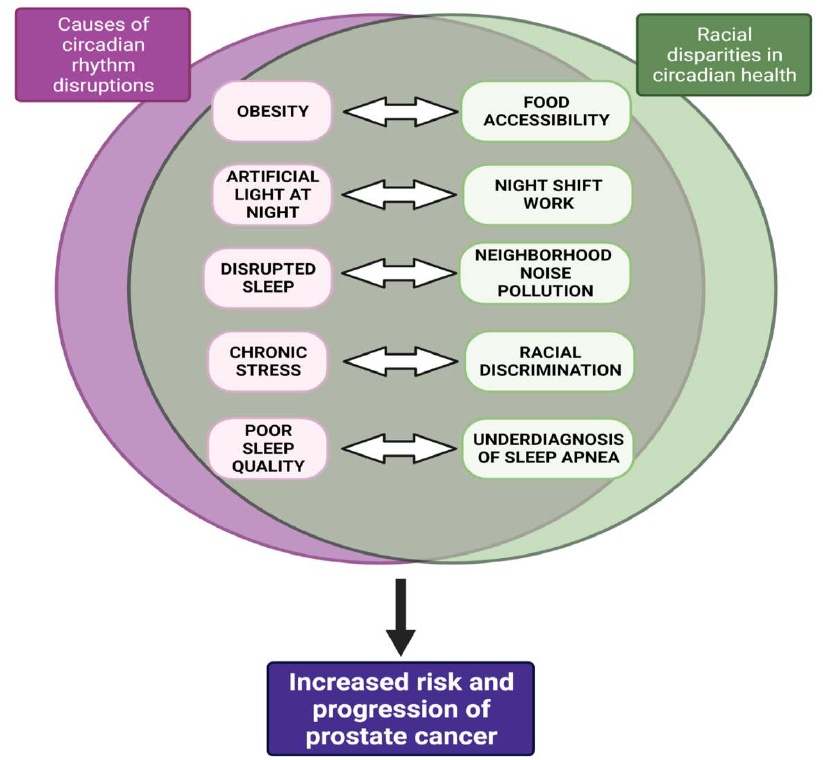
Figure 2. Overlapping Risk Factors for Circadian Rhythm Disruptions and Racial Disparities in Circadian health regarding Prostate Cancer Risk. The right-hand side of the Venn diagram describes environmental, structural, and health-related factors that contribute to the racial disparities in cir- cadian health. Specifically, these factors disproportionately affect the AA population compared to other racial/ethnic groups. The left-hand side outlines the causes of circadian rhythm disruptions. The arrows inside the Venn diagram indicate that there is a bidirectional relationship between the causes of CRDs and social determinants of health. Taken together, the top half of the model illus- trates how the African American population is disproportionately at risk for developing CRDs. The bottom half of the model focuses on the downstream effects of circadian rhythm disruption on pros- tate cancer, both in incidence and aggressiveness. Residential segregation is a fundamental contributor to racial disparities in health outcomes and may contribute to fragmented sleep among racial/ethnic minorities. This form of discrimination was legitimized through “redlining”, a historical housing segrega- tion policy that entitled banks to deny mortgages based on race and grant loans for Black